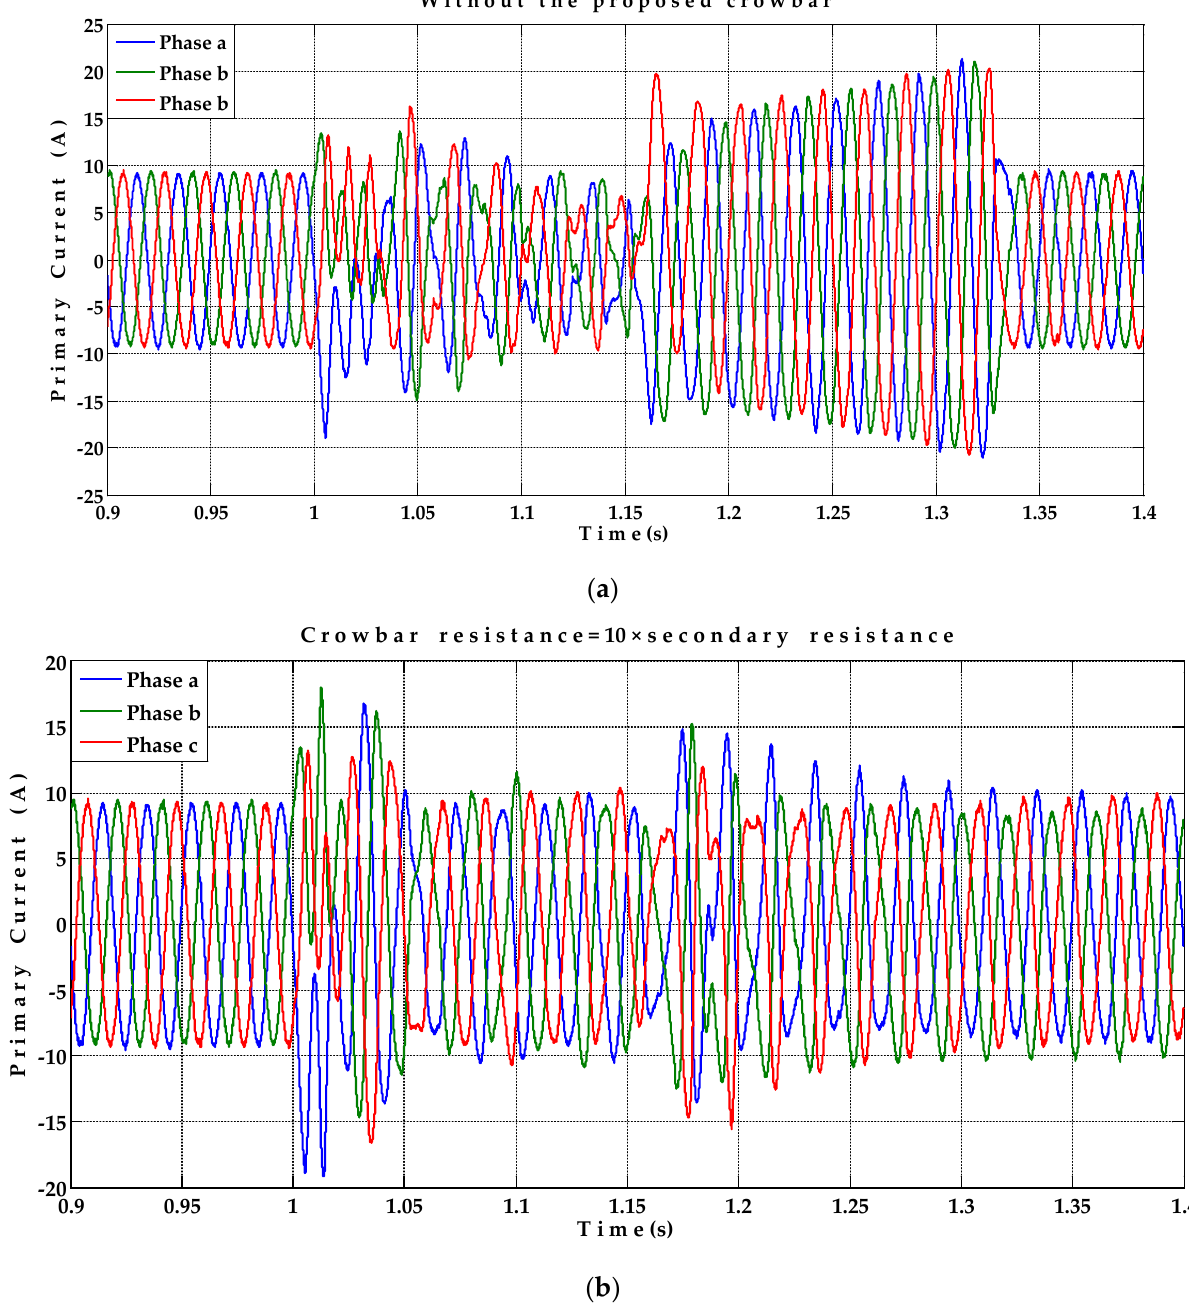
Figure 10. Primary current of BDFRG without and with the proposed crowbar protection under symmetrical fault occurrence: ( a ). Without the proposed crowbar; ( b ). With the proposed crowbar.